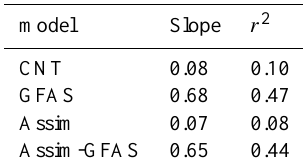
Table 13. Slope and correlation ( r 2 ) of modeled HCHO columns for hindcast D+0 with respect to SCIAMACHY and OMI observations over western Russia between 20 July and 15